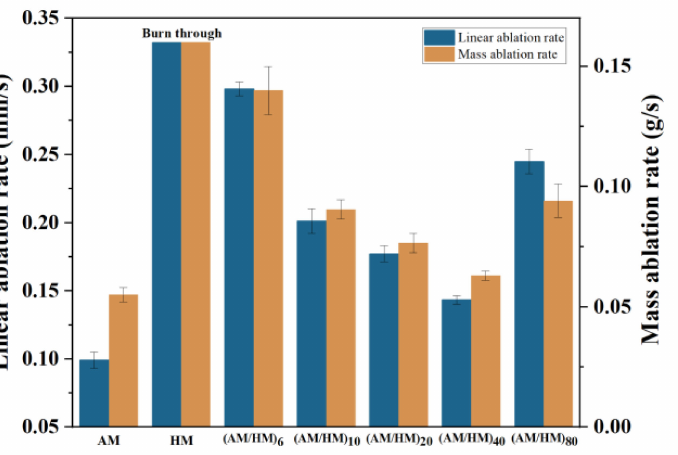
Figure 11. Variation in linear ablation rate ( R l ) and mass ablation rate ( R c ) as functions of layer